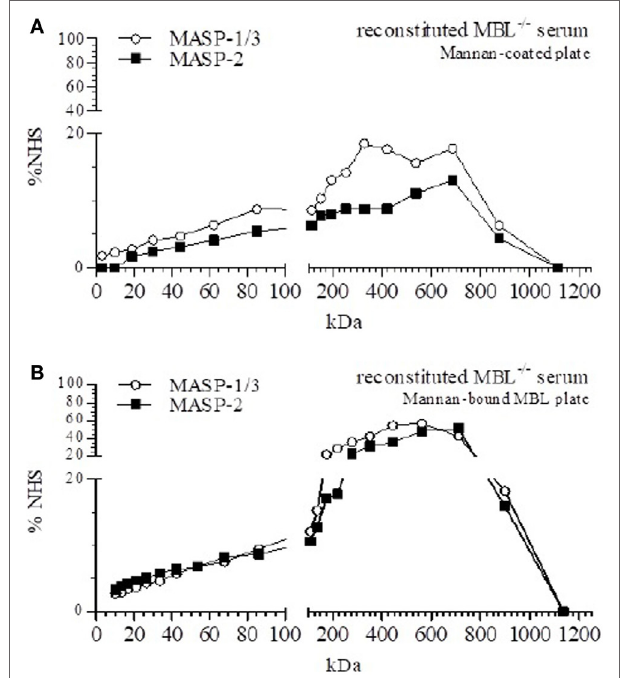
FigUre 3 | Size-exclusion chromatography (SEC) of mannan-binding lectin (MBL)-reconstituted MBL-deficient serum. SEC of MBL-deficient serum reconstituted to 50 µg/ml MBL. (a) Fractions were tested for the presence of MBL–MBL-associated serine protease (MASP)-1/3 and MBL–MASP-2 complexes on mannan-coated plates. (B) Mannan-coated plates were pre-incubated with MBL, and followed by the different fractions of reconstituted MBL-deficient serum, and the formation of MBL–MASP-1/3 and MBL–MASP-2 complexes was